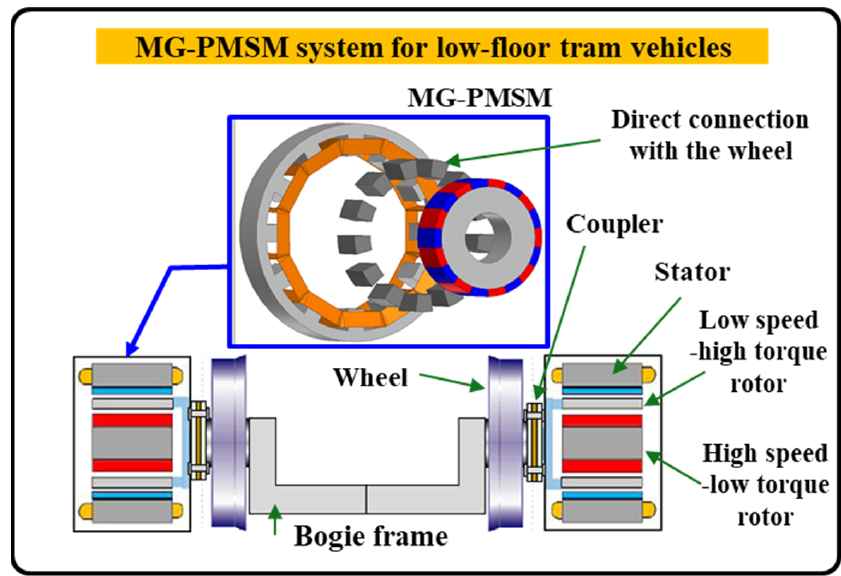
Table 1. MG ‐ PMSM design criteria through installation space analysis.